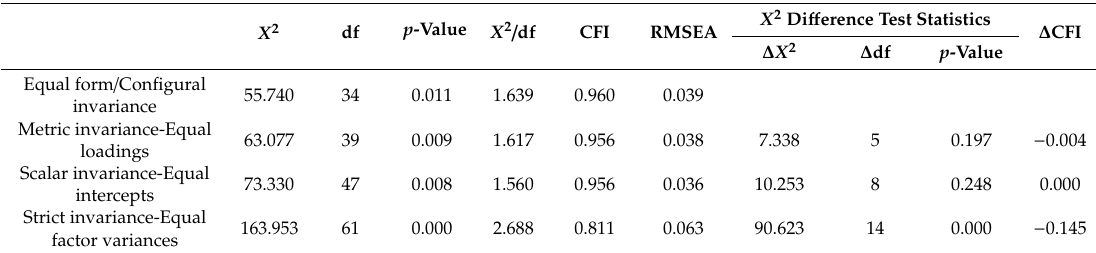
Table 6. Measurement invariance of the 3-factor model of the Athens Insomnia Scale (AIS) among occupational computer users in